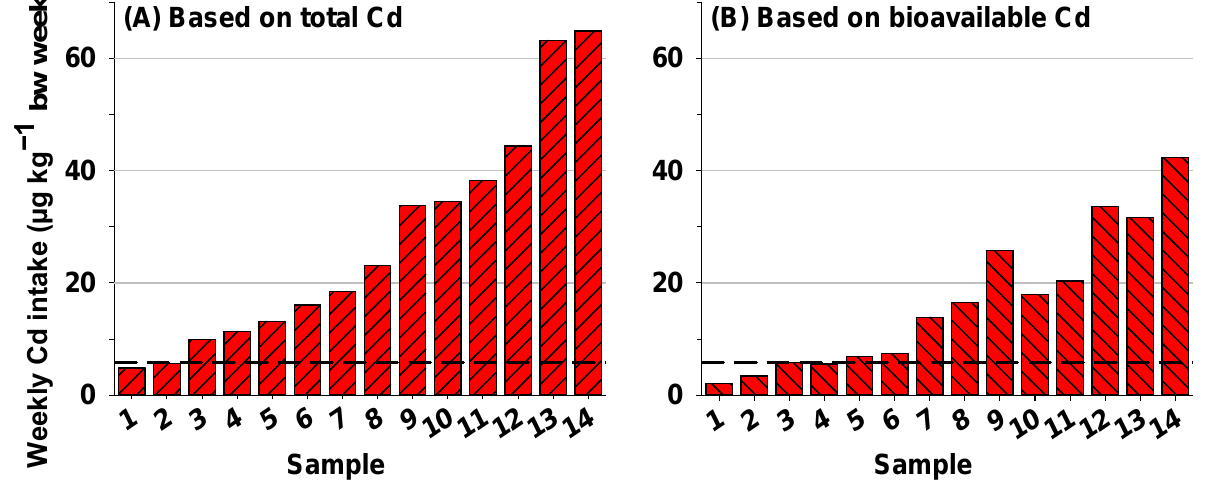
Figure 4. Weekly dietary Cd intake levels estimated using total Cd concentration in rice ( A ) and bioavailable Cd concentration in rice ( B ). Weekly dietary Cd intake via oral ingestion of rice was calculated for an adult with a body weight of 60 kg and a rice consumption rate of 1.53 kg/week. The black dashed lines indicate the tolerable intake level of 5.80 μg/kg bw/week for Cd proposed by JECFA to protect human health.